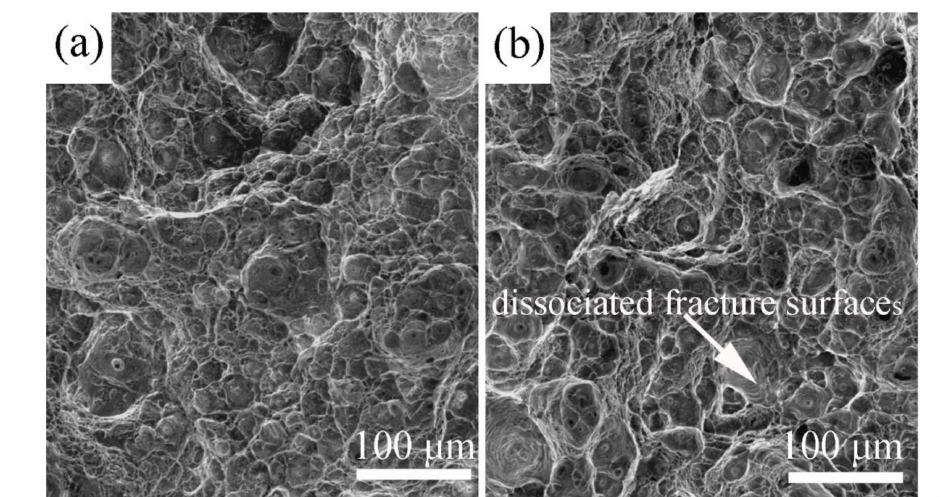
Figure 6. The SEM photographs of fracture morphology of tensile specimens that experienced fatigue tests of 50,000 cycles under the load of 450 MPa, ( a ) with magnetic field and ( b ) without magnetic